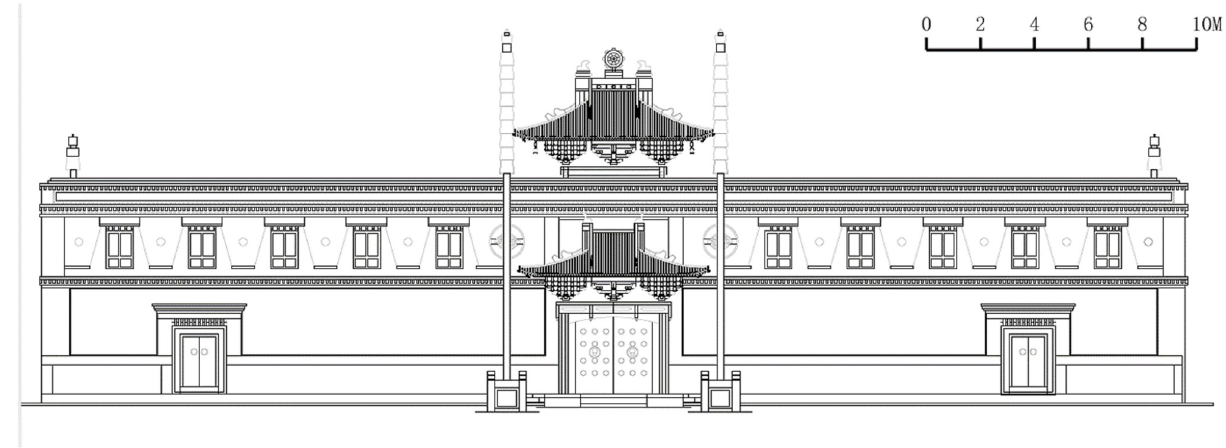
Fig 11. Elevation of the Great Chanting Hall.